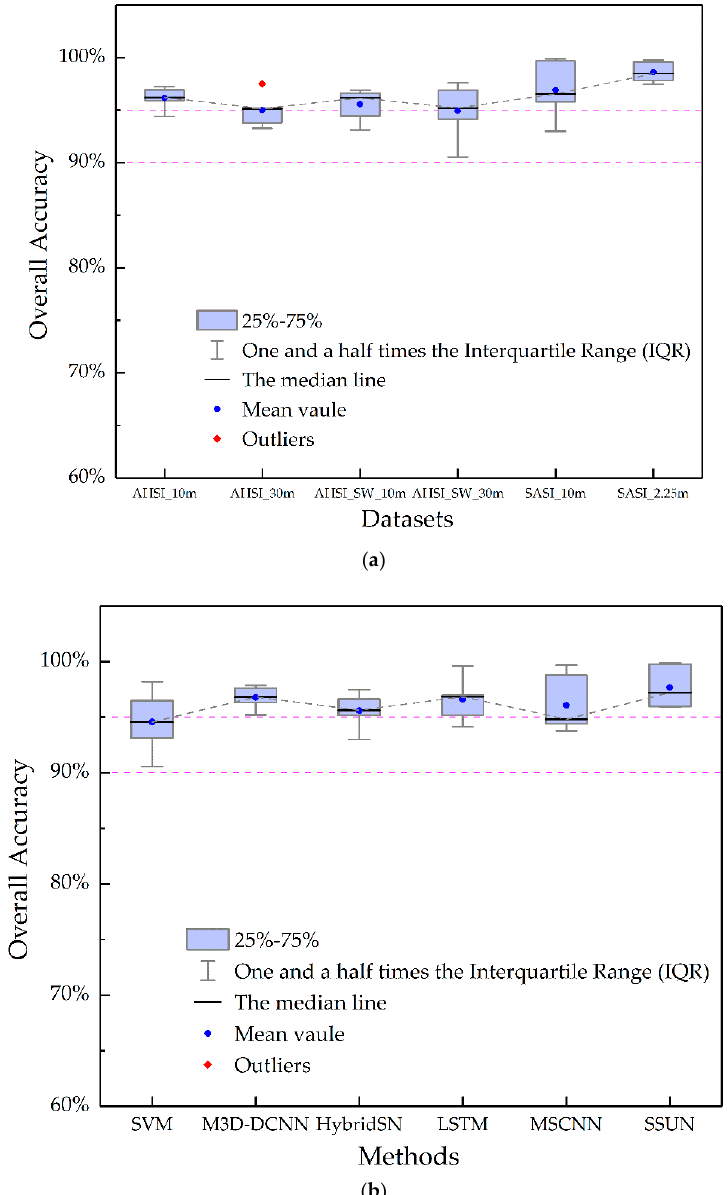
Figure 7. Boxplots of overall accuracy for every ( a ) dataset and ( b ) method.